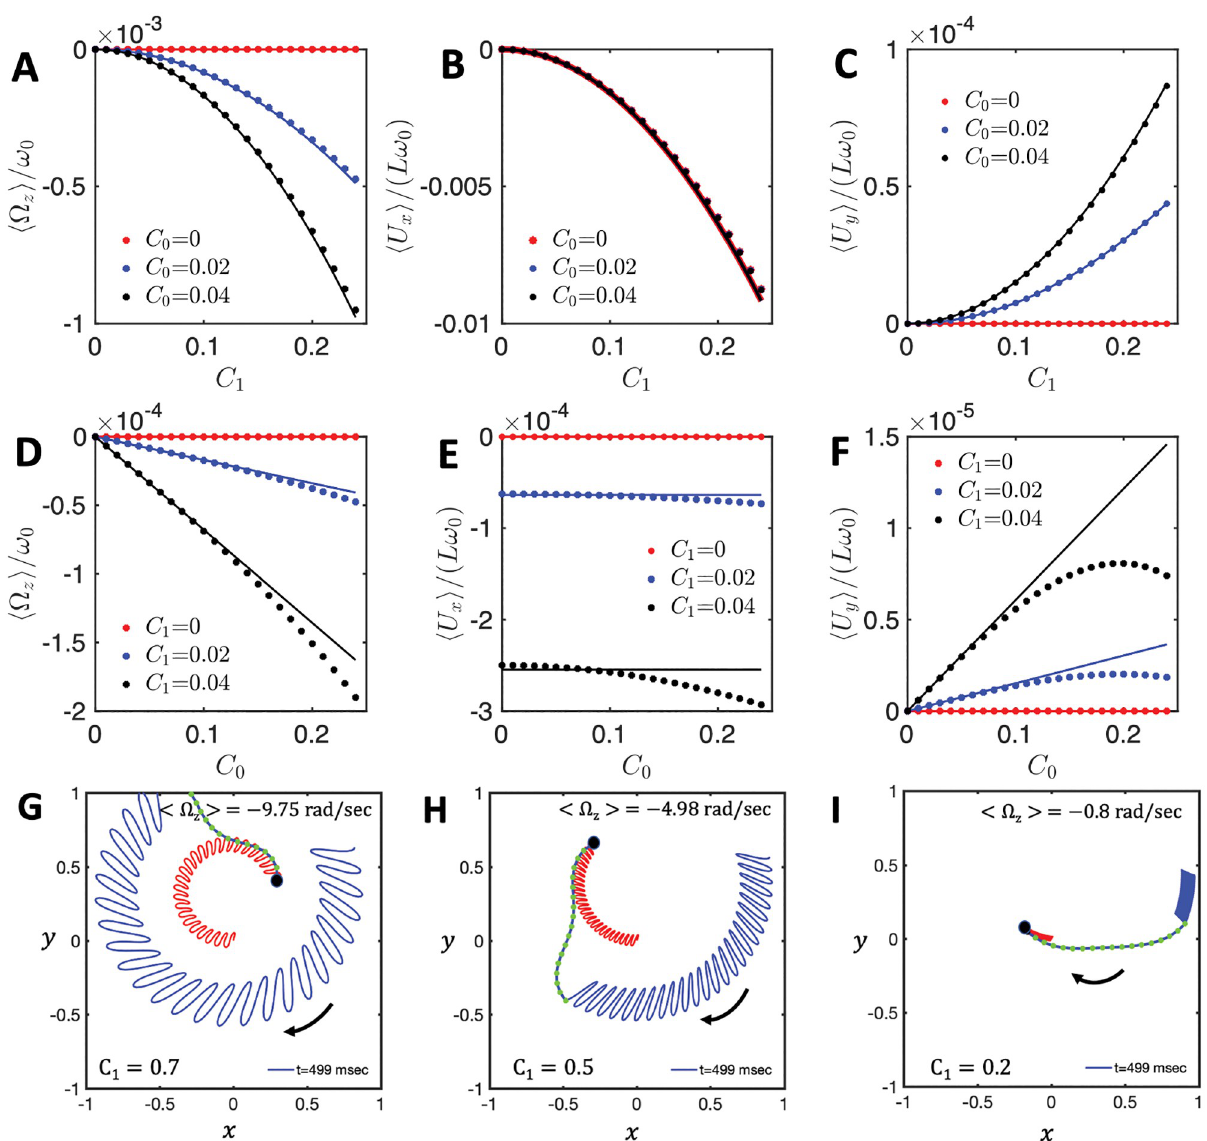
Fig 4. A-F) Comparison between the analytical approximations for the rotational and translational velocities, Eqs 20–22 (solid lines), and the results of numerical simulations (dots) for bead radius of R = 0. G-I) Numerical simulations performed with the simplified waveform to show the effect of C 1 . A bead of radius R , with r = R / L = 0.1, is attached symmetrically to a model flagellum. At a fixed value of the static curvature, C 0 = 0.2, the mean rotational velocity decreases as the amplitude of dynamic mode C 1 decreases from G) C 1 = 0.7, to H) C 1 = 0.5 and further to I) C 1 =